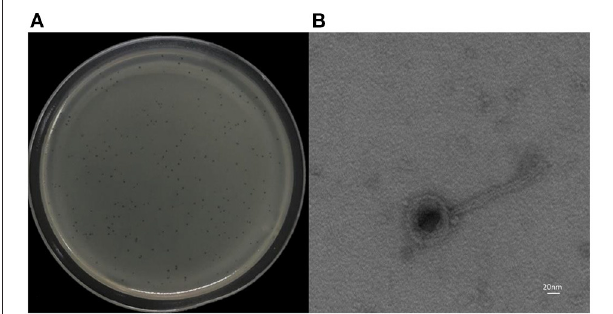
FIGURE 1 | Morphology of phage vB_Kpn_B01. (A) Plaques of the phage; (B) transmission electron micrograph of the phage.